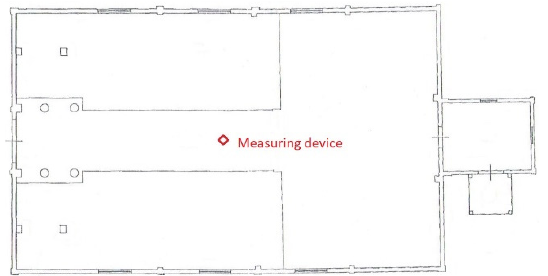
Figure 6. Turaida church plan with the location of the measuring device.